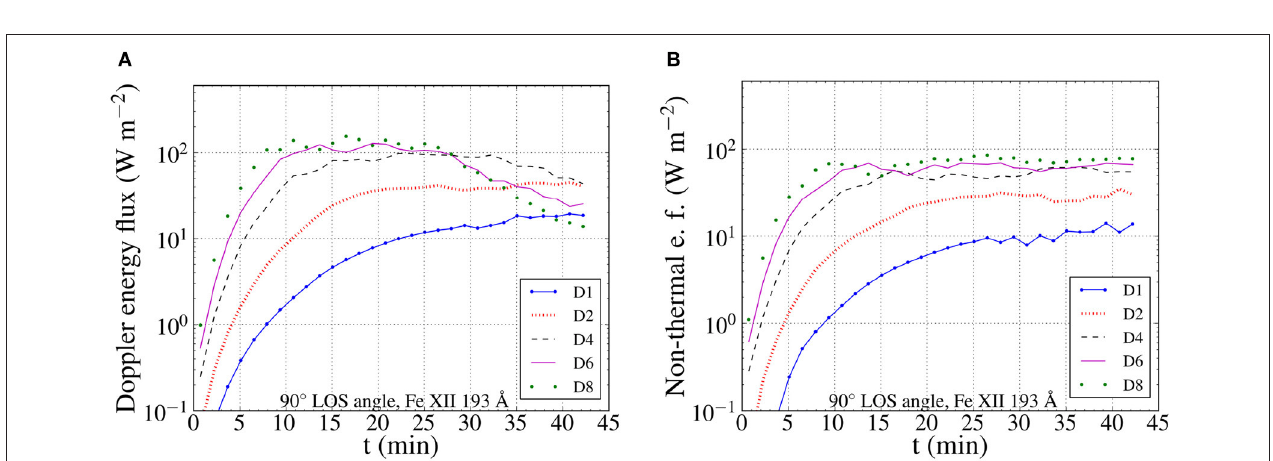
FIGURE 7 | Average values of the Doppler (A) and non-thermal (B) energy fluxes for a LOS angle of 90 ◦ , based on synthetic spectroscopic data from the Fe XII 193 Å line.